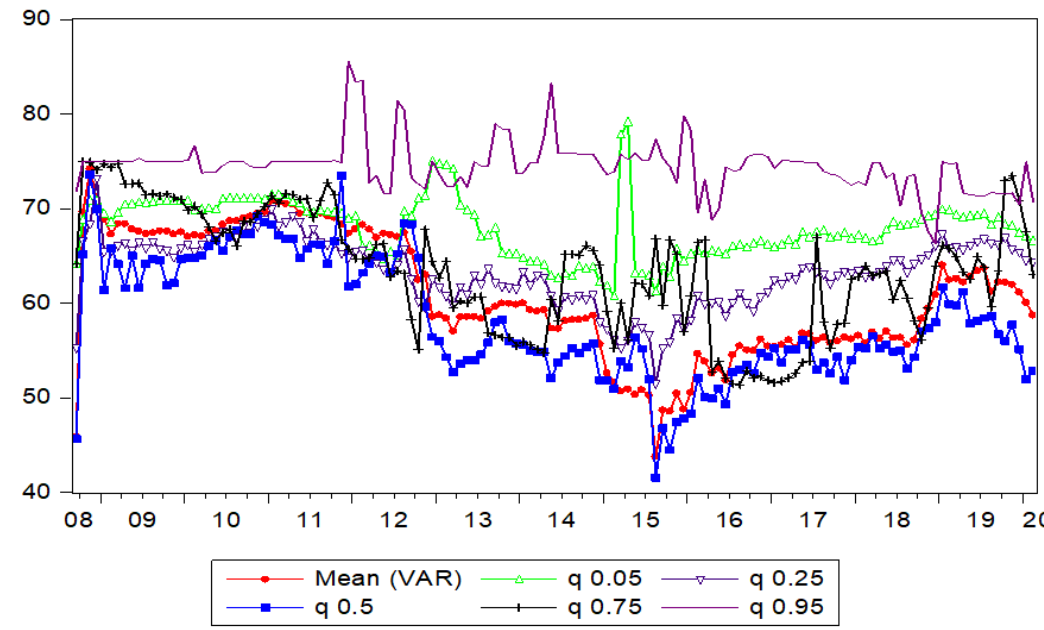
Figure 7. Comparing the total volatility spillovers between the linear VAR (mean) and different quantiles by the QVAR model among the clean energy (CE), S&P 500 (ST), technology (TE), and crude oil (WTI) series. Note: The x -axis indicates the time and the y -axis shows the percentage change in the total spillover index in the mean and different